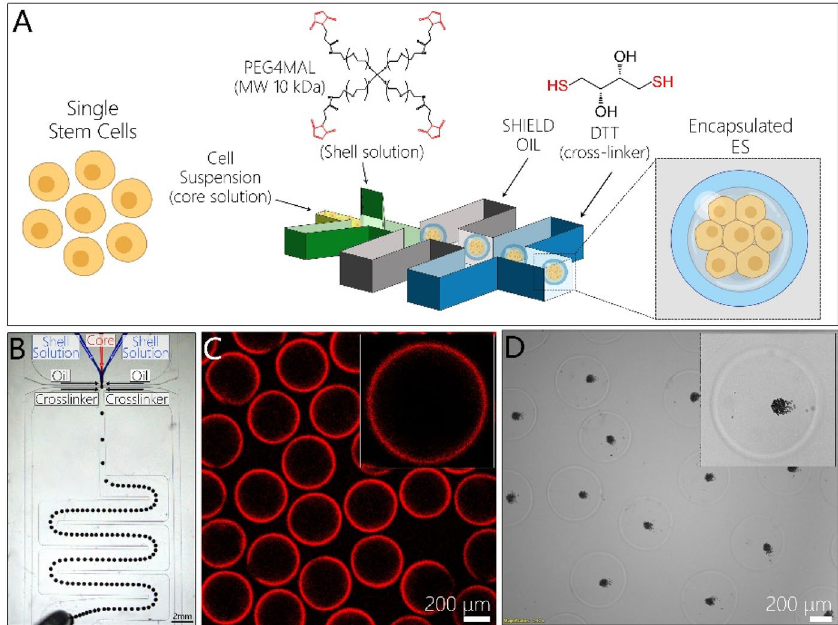
Figure 1. Fabrication of core–shell microcapsules with PEG gel shell and aqueous core. ( A ) Schematic illustration of cell encapsulation process. ( B ) Top view of coaxial flow-focusing device generating a train